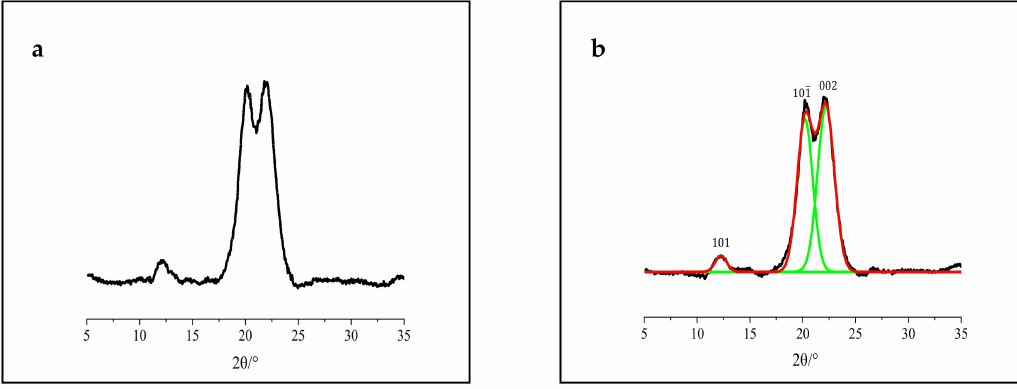
Figure 3. XRD patterns of α -cellulose: ( a ) original XRD patterns and ( b ) peak separation results.